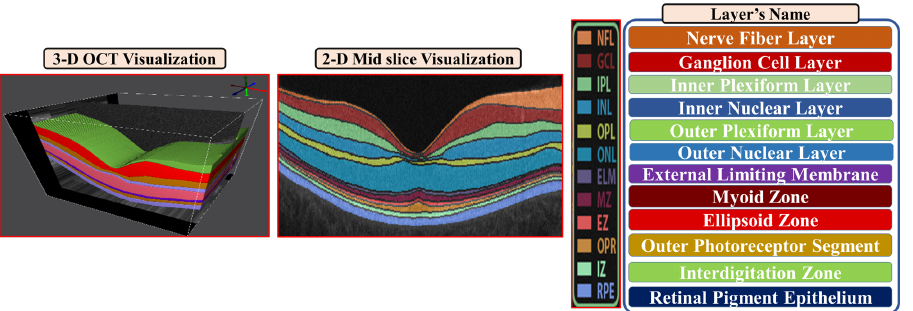
Figure 2. A 3D-OCT visualization of the layer segmentation (left). On the right, a description of twelve layers starting from layer one (the nerve fiber layer (NFL)) and ending with layer 12 (retinal pigment epithelium (RPE)).